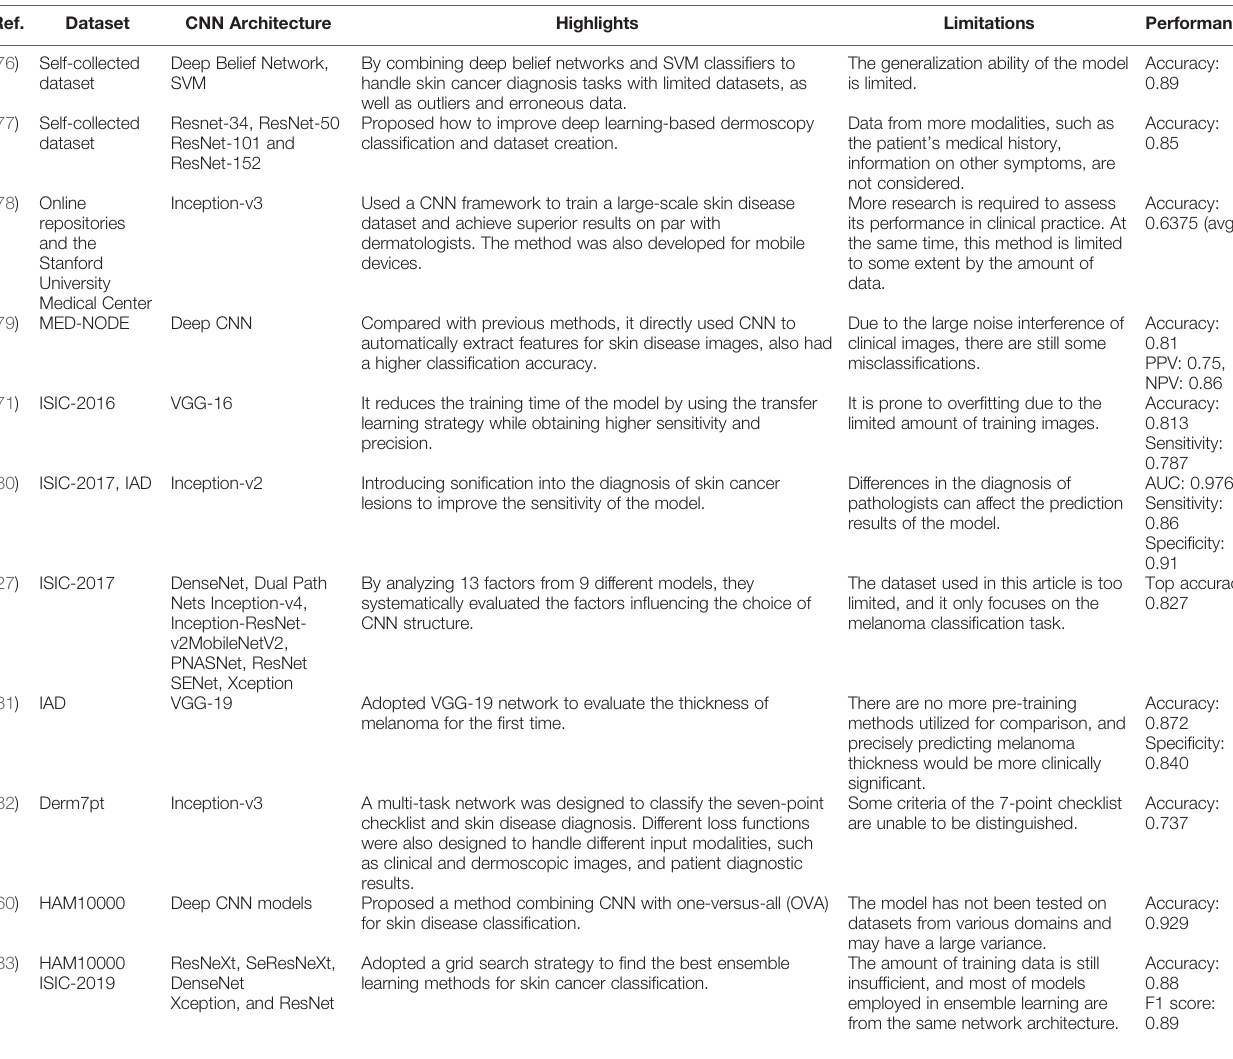
TABLE 3 | References of skin cancer classi fi cation with typical CNN frameworks.